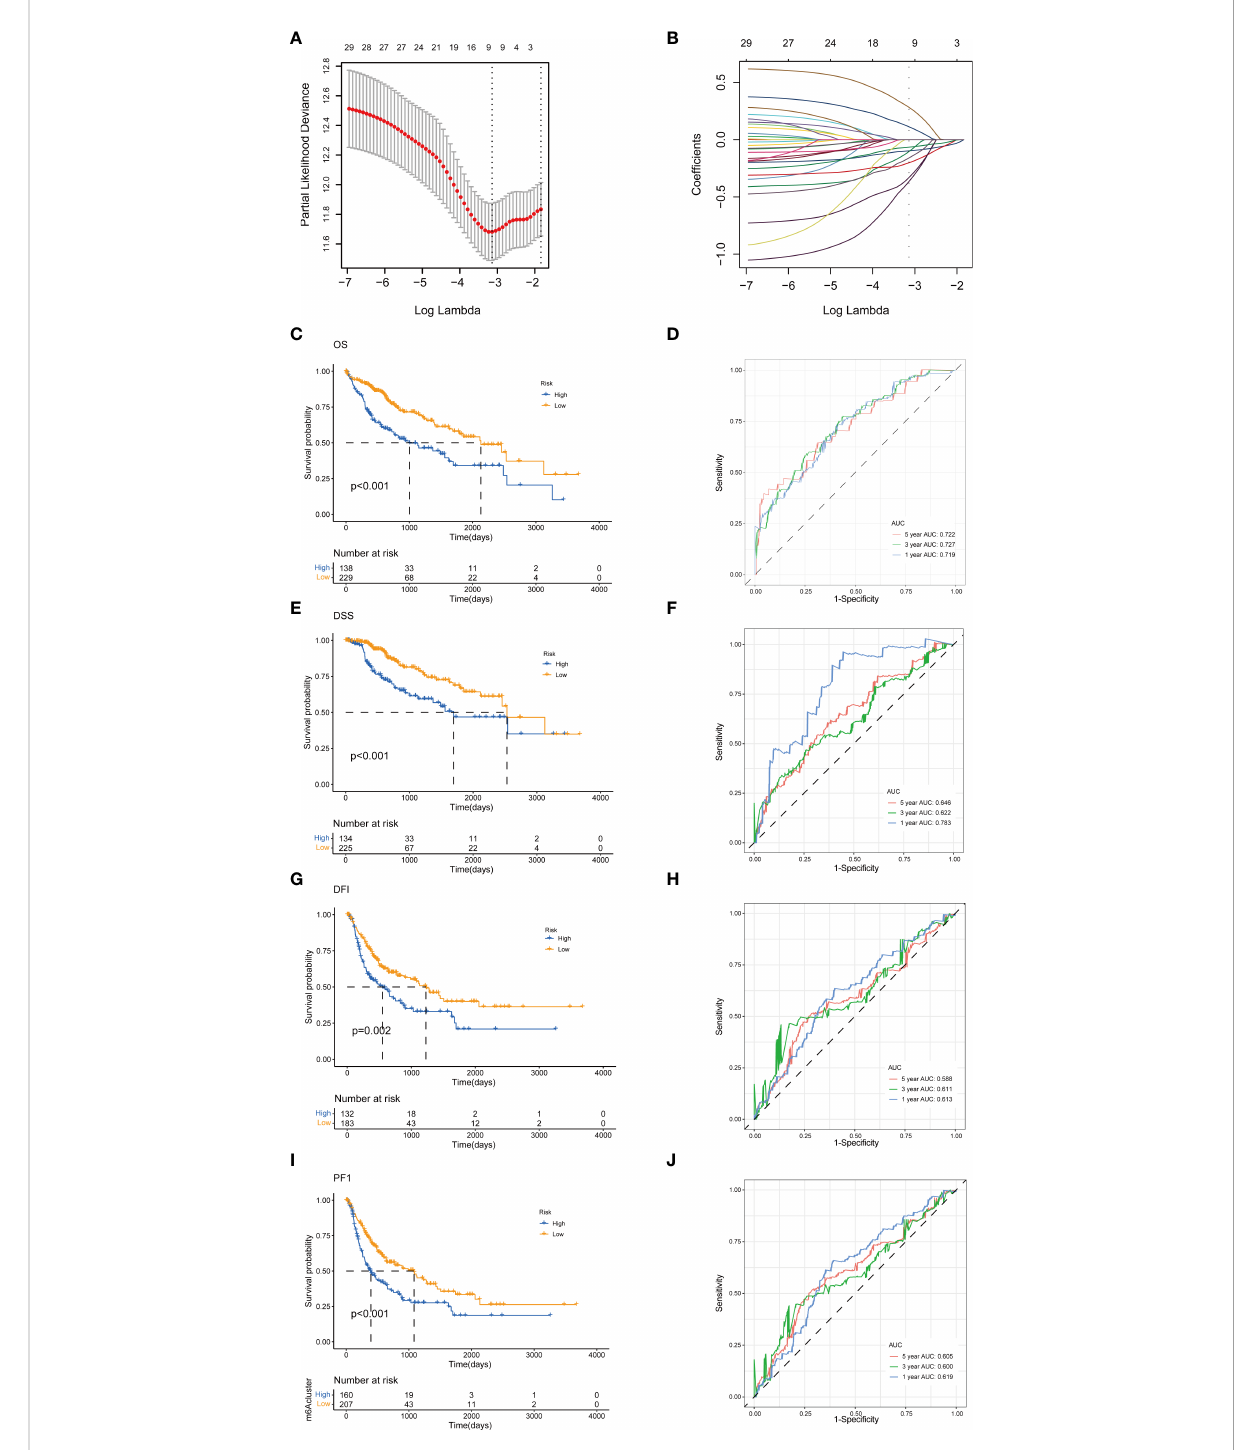
FIGURE 5 Construction of tyrosine metabolism-related genes prognostic model in the training set. (A) Ten-time cross-validation for tuning parameter selection by LASSO regression. (B) The screening of coef fi cients under LASSO analysis. A vertical line is drawn at the value chosen by 10 ‐ fold cross ‐ validation of overall survival. Kaplan-Meier curves for survival outcomes of the two risk subtypes according to the OS (C) , DSS (E) , DFI (G) , and PFI (I) (log-rank tests, p< 0.01). ROC curves to predict the sensitivity and speci fi city of 1-, 3-, and 5-year survival rates according to the risk score based on the OS (D) , DSS (F) , DFI (H) , and PFI (J) . LASSO, least absolute shrinkage and selection operator; OS, overall survival; DSS, disease-speci fi c survival; DFI, disease-free interval; PFI, progression-free interval; ROC, receiver operating